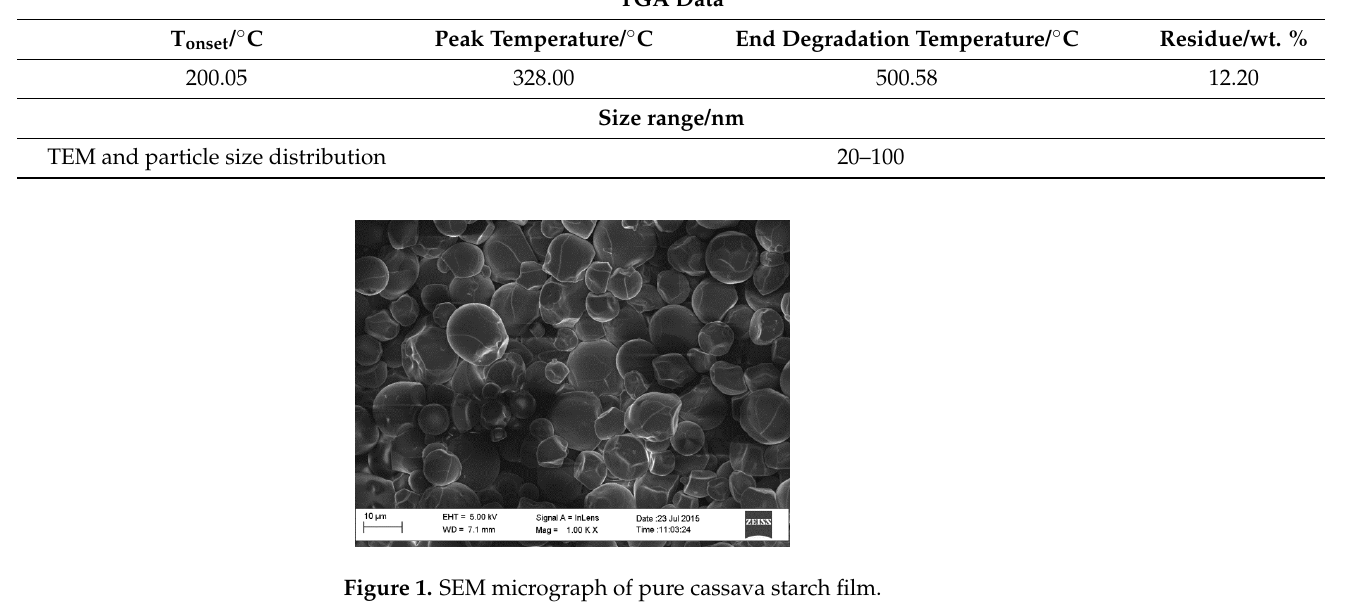
Table 1. The characteristics of the used cellulose nanofiber prepared from bamboo ( Bambusa vulgaris schrad).